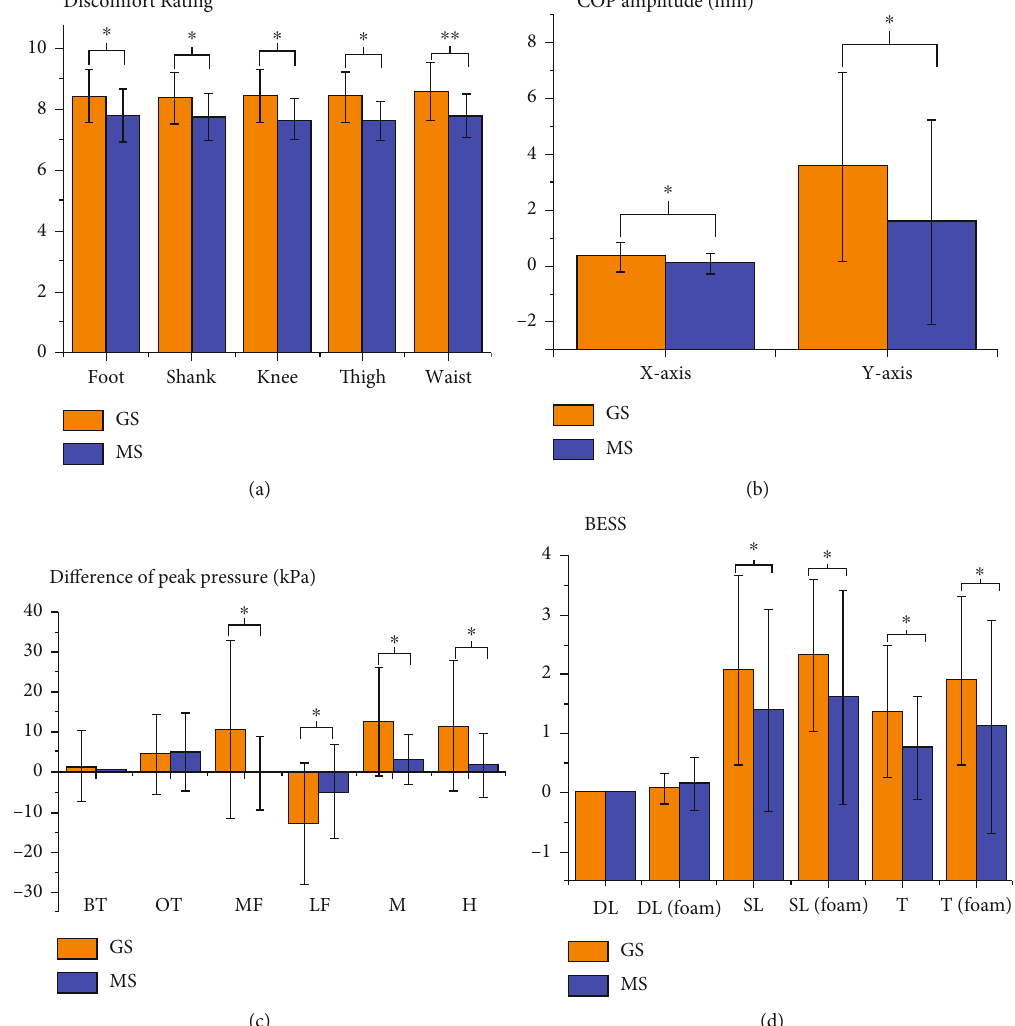
Figure 6: Comparisons of perceived exertion and foot biomechanical parameters. (a) Perceived exertion. (b) COP amplitude. (c) Peak plantar pressure. (d) balance error